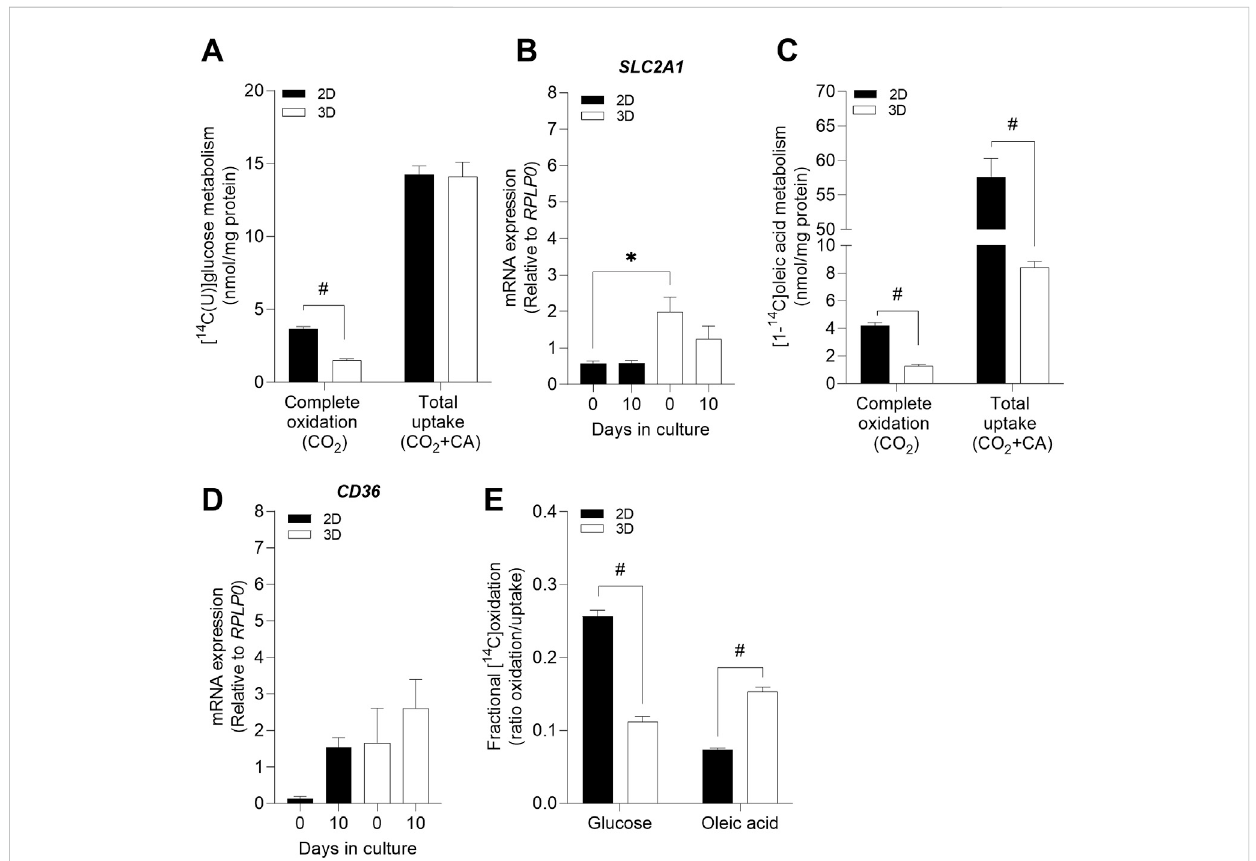
FIGURE 4 Comparison of glucose and oleic acid metabolism between 2D myotube cultures and 3D muscle spheroids. Myospheres were differentiated for 10 days and D-[ 14 C(U]glucose (0.5 μ Ci/mL, 200 µM) or[1- 14 C]oleic acid (0.5 μ Ci/mL, 100 µM), respectively,wereused in 4 hsubstrate oxidation assay to assess the metabolic pro fi le. (A) Complete oxidation and total D-[ 14 C (U]glucose uptake in 2D and 3D cell models. (B) mRNA expression of solute carrier family2member1( SLC2A1 )(glucosetransporter)atdays0and10ofdifferentiation,normalizedto housekeepinggene( RPLP0 ). (C) [1- 14 C]oleicacid complete oxidation and uptake in 2D and 3D cell model ’ s metabolism. (D) mRNA expression of the fatty acid transporter CD36 at days 0 and 10 of differentiation, normalized to housekeeping gene ( RPLP0 ). (E) Fractional oxidation (ratio of substrate oxidation/uptake) of glucose and oleic acid in 2D and 3D cell models. Results are represented as mean ± SEM. # p < 0.05 by unpaired t -test; * p < 0.05 by ordinary one-way ANOVA